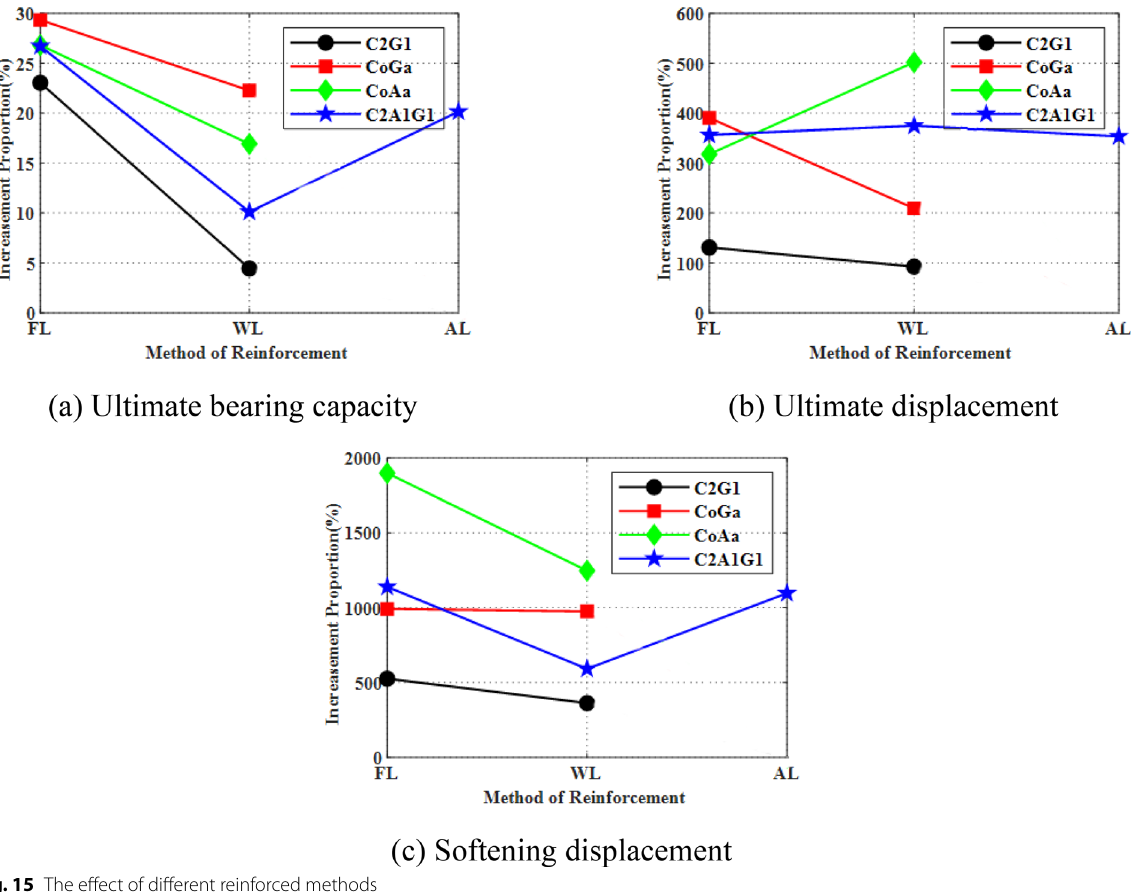
Fig. 15 The effect of different reinforced